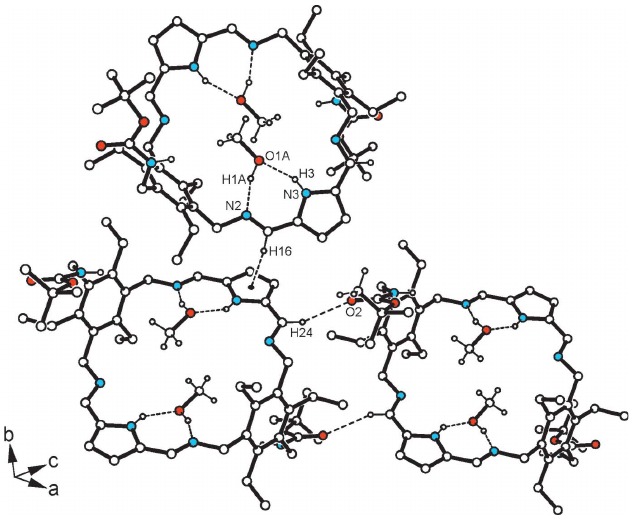
Figure 2 Part of the crystal structure of the 1:2 host–guest complex showing the mode of non-covalent intermolecular bonding. For the sake of clarity, the H atoms of the host molecule not involved in hydrogen-bonding interactions are